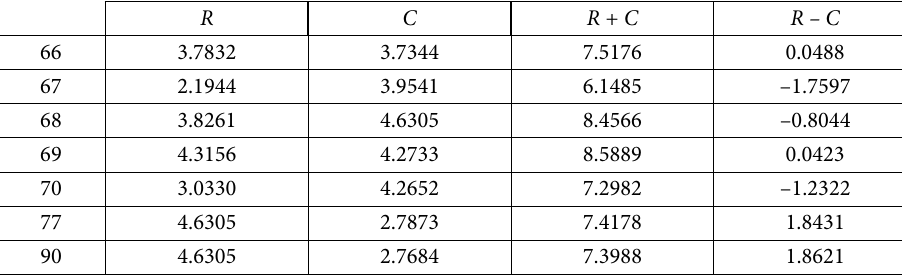
Table 20. Auxiliary calculations for C3 Processes